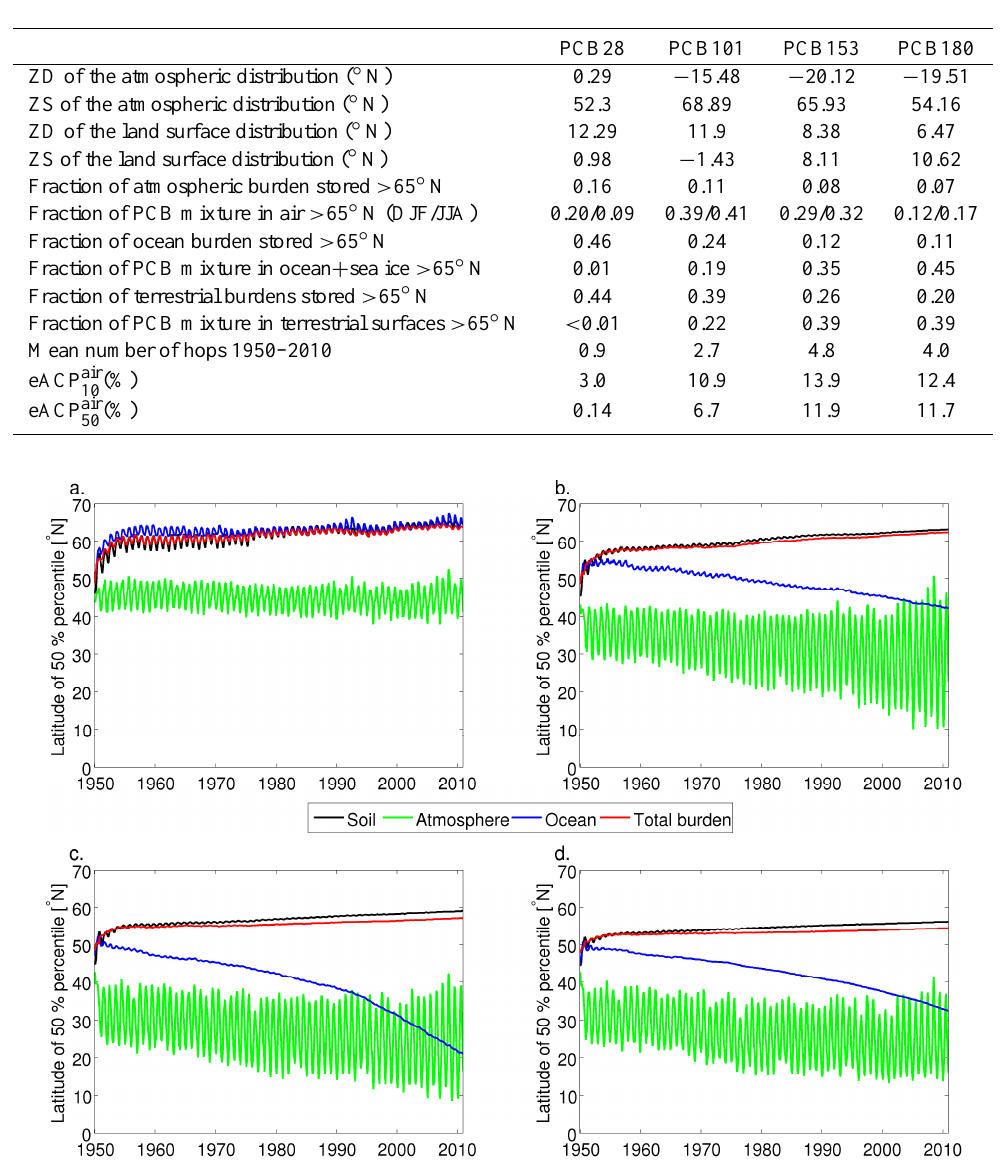
Fig. 3. Meridional shifts of the center of gravity (COG) of the cumulative meridional distributions of the compartmental burdens of (a) PCB28, (b) PCB101, (c) PCB153 and (d) PCB180, 1950–2010.